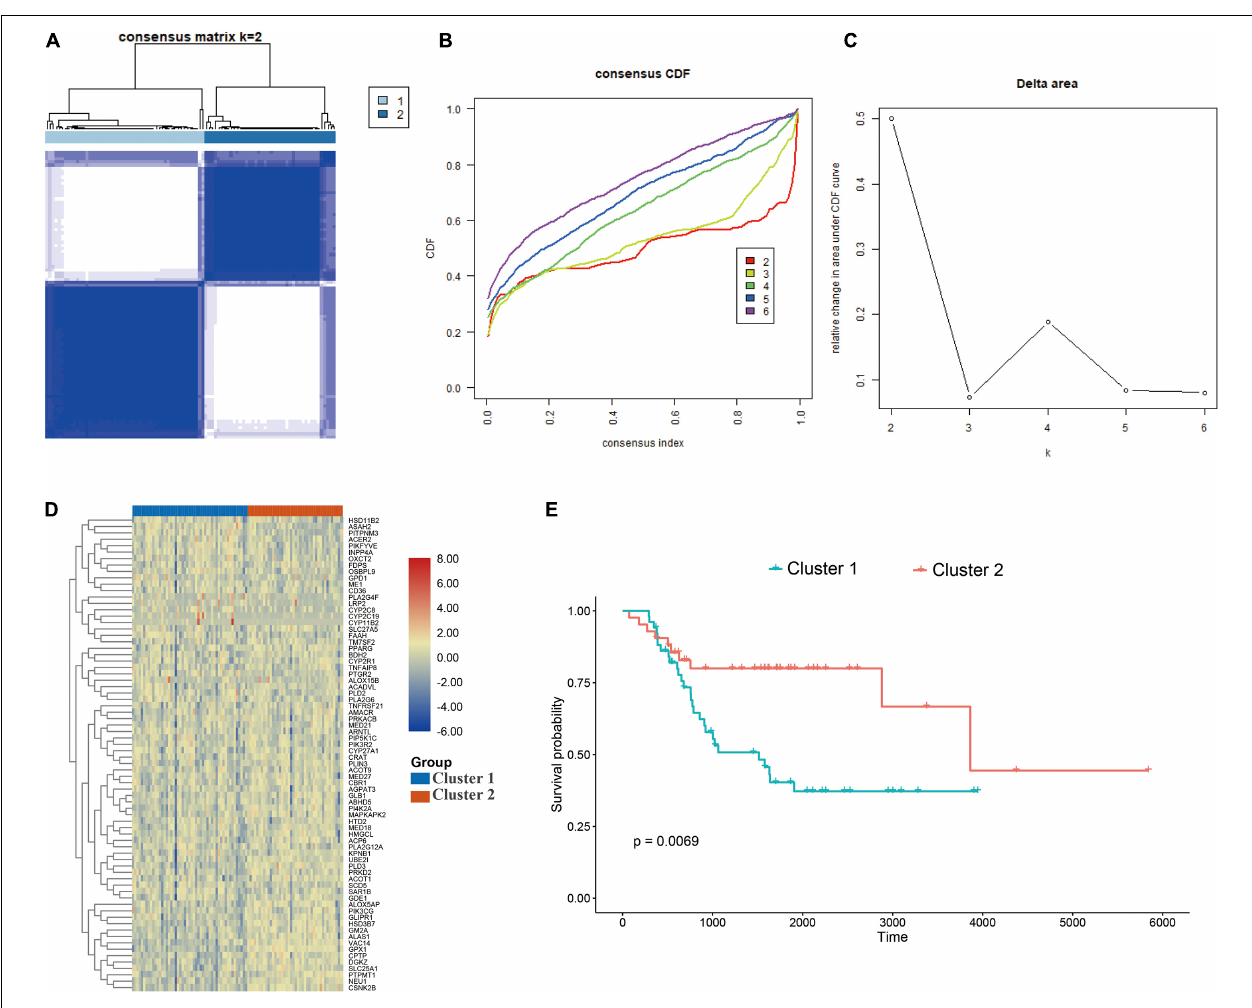
FIGURE 2 | Consensus cluster. (A–C) K = 2 was identified the optimal value for consensus clustering, (D) heatmap visualizing the expression of lipid metabolism gens in the two subgroups, (E) survival curve of the patients in the two subgroups.